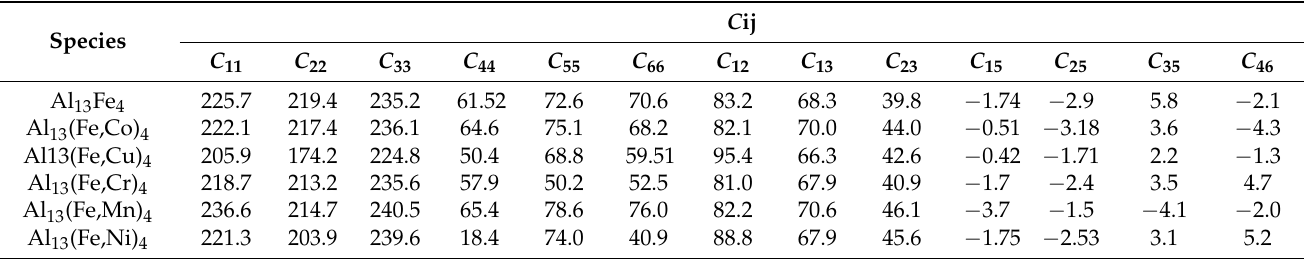
Figure 4. The electron density difference distribution of Al 13 (Fe,M) 4 phases with different elements doping on the plane (010). ( a ) Al 13 Fe 4 , ( b ) Al 13 (Fe,Co) 4 , ( c ) Al 13 (Fe,Cu) 4 , ( d ) Al 13 (Fe,Cr) 4 , ( e ) Al 13 (Fe,Mn) 4 , ( f ) Al 13 (Fe,Ni) 4 . Table 4. Estimated elastic constants (in GPa) of Al 13 (Fe,M) 4 phases with different elements